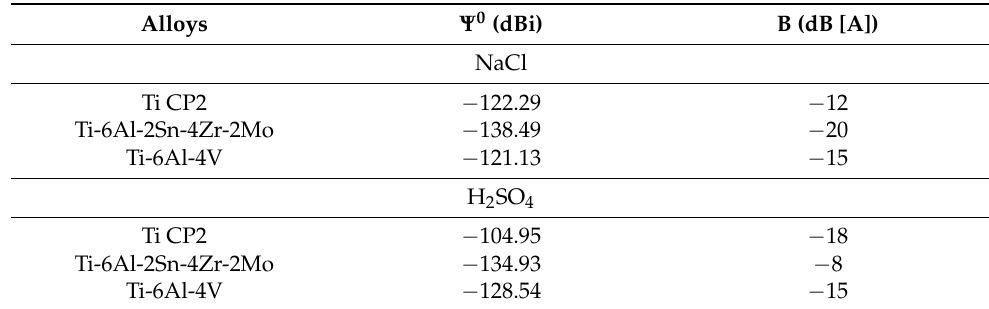
Figure 4. Potential spectral density (PSD) in current for ( a ) NaCl and ( b ) H 2 SO 4 . Table 5. Parameters obtained by PSD.